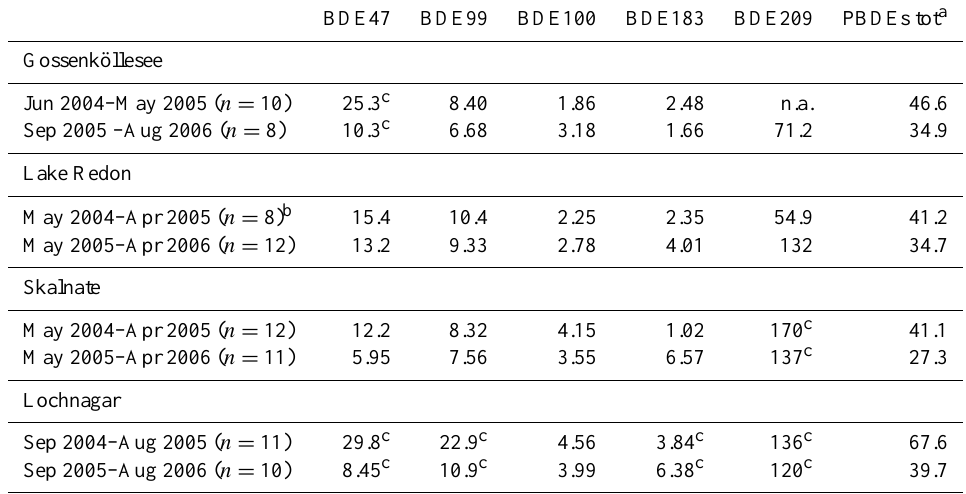
Table 5. Temporal variations of mean atmospheric deposition fluxes of PBDEs to remote sites. Values expressed in ngm − 2 mo − 1 .